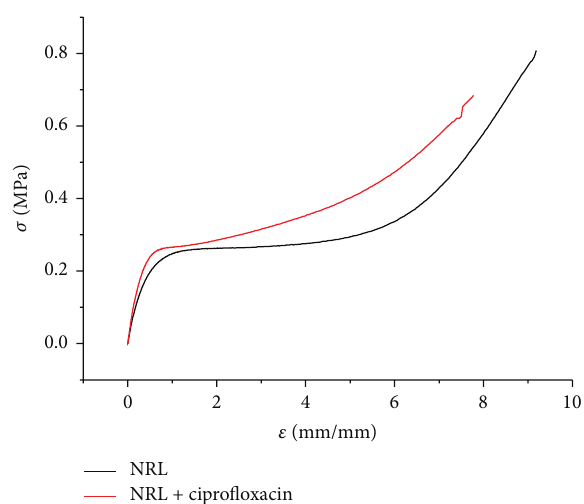
Figure6:Representativestress-straincurvesNRLandciprofloxacin loaded